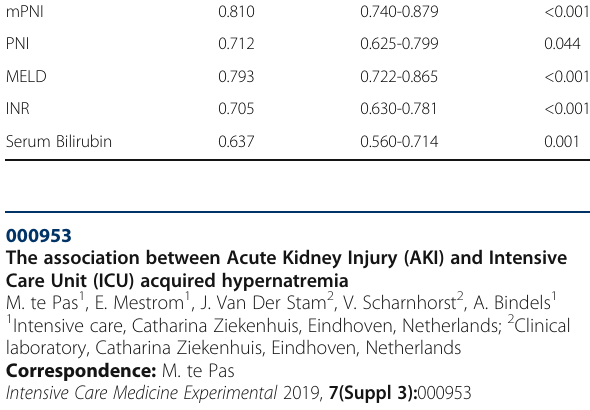
Table 1 (abstract 000800). Receiver operating characteristic curve